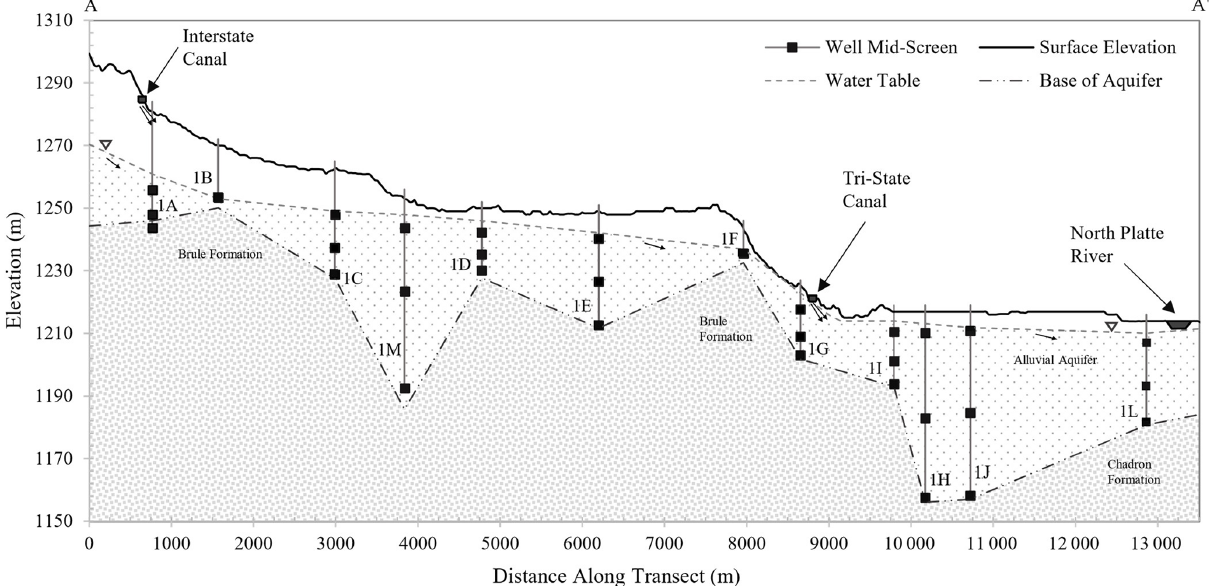
Figure 2. Cross section along representative well transect (see Fig. 1) within the Dutch Flats area. Surface elevation data were derived from a 30m digital elevation model (USGS, 1997). Water surface and base of aquifer elevations were sourced from a 1998 Dutch Flats